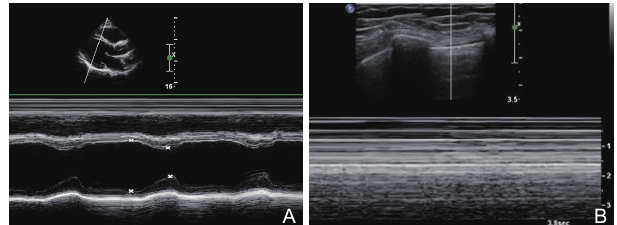
A Figure 5 M-mode ultrasound image. (A) M-mode echocardiogram of the heart; (B) M-mode echogram of normal lung. The vertical axis (Y axis) represents distance; the horizontal axis (X axis) represents time. The echoes of different depths are expanded with time to form a time-motion curve.